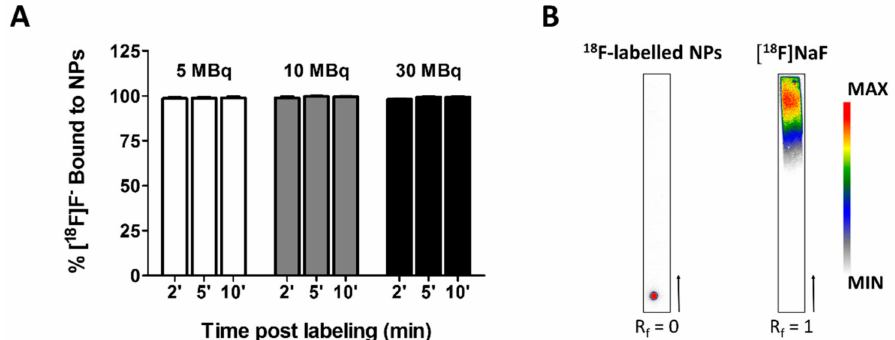
Figure 9. Time course of the radiolabeling of Fe 3 O 4 @Al(OH) 3 NPs with [ 18 F]F − . ( A ) Graphical representation of the percentage of [ 18 F]F − bound to NPs containing 1.34 mg / mL iron after two, five